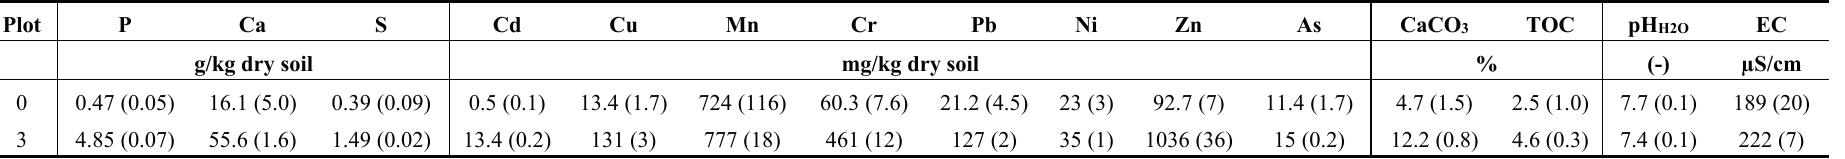
Table 4. Properties of the uncontaminated (from Plot 0) and contaminated (from Plot 3) soil used in the first and second greenhouse trial. Values are the averages for four replicates with the standard deviation in brackets.